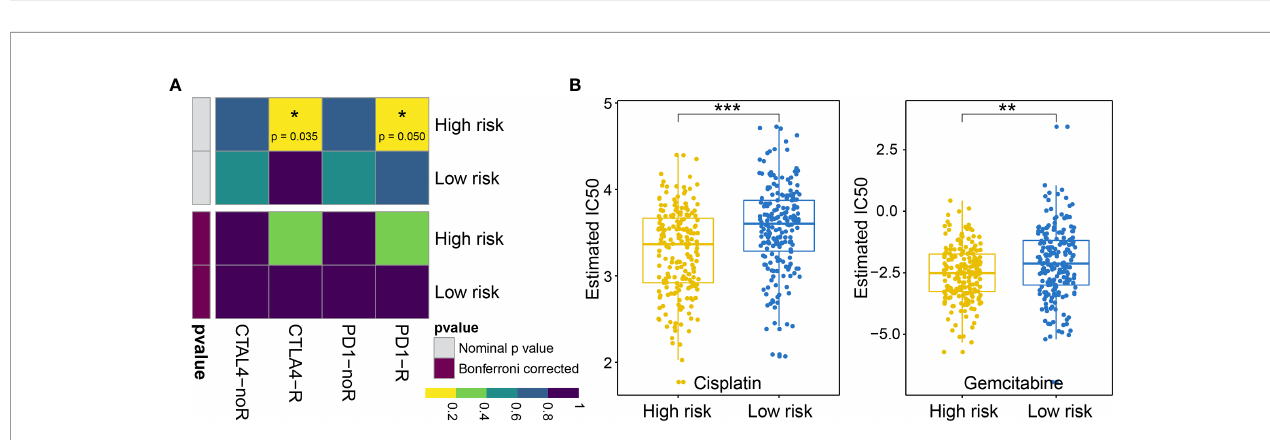
FIGURE 8 | (A) The consensus matrix of BLCA de fi nes three sample clusters. (B, C) Kaplan – Meier survival curves for BLCA associated with different AS clusters for OS and DFI. (D) Heatmap showing AS events and the distribution of clinical information across different AS clusters in BLCA.